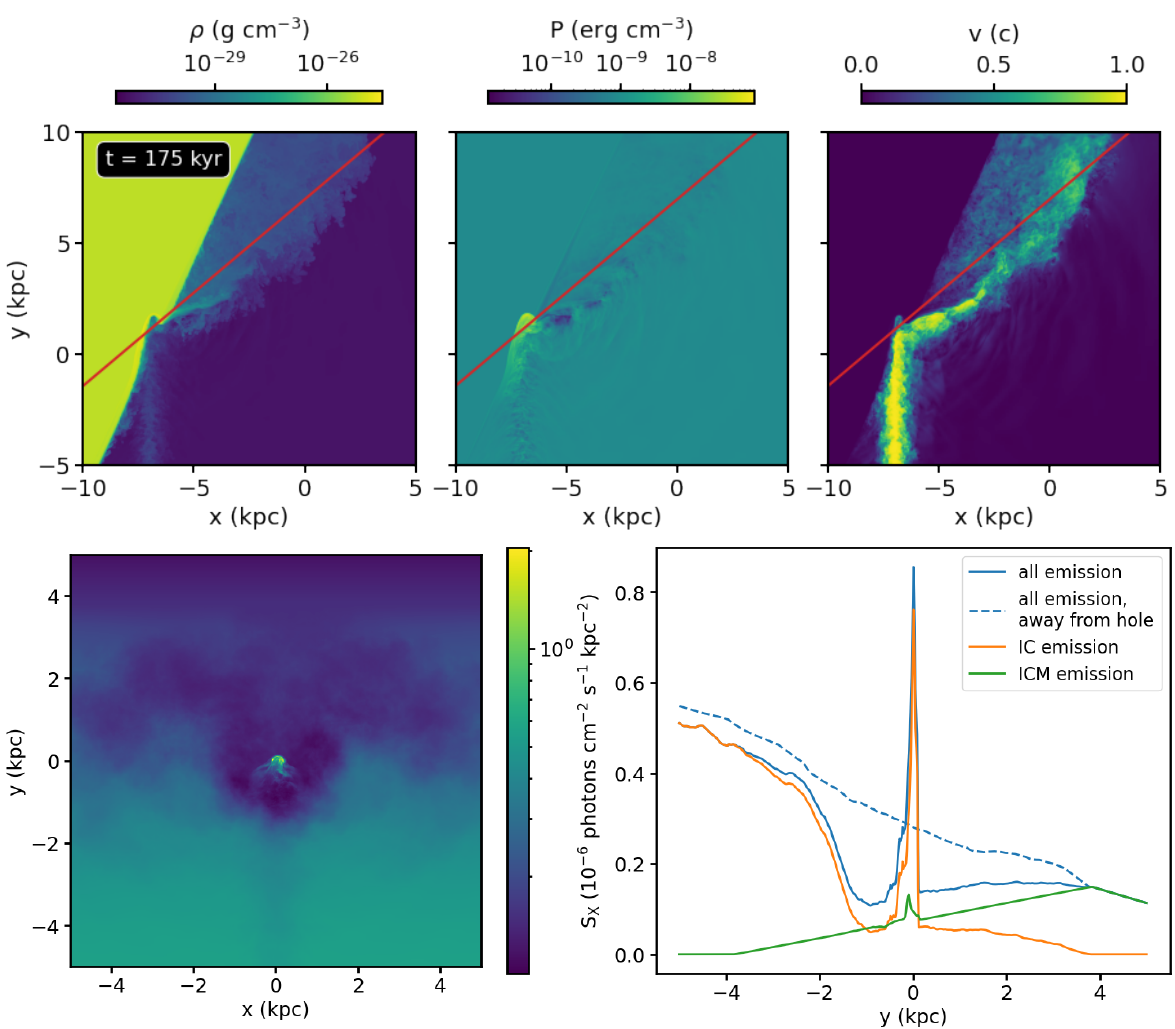
Figure 9. The appearance of a hole in X-ray emission due to Doppler de-boosting from the reflected jet. ( Top panels) Slices through the gas density, pressure, and velocity magnitude at t = 175 kyr, showing the line of sight of the projection in the bottom panels with a red line. ( Bottom-left panel) The projected X-ray surface brightness from all components along the chosen sight line, showing a hole of emission surrounding a hotspot. ( Bottom-right panel) Profiles taken through the center along the y -axis of the map at x = 0, showing separate IC-CMB and ICM thermal emission, as well as total emission in the hole region and away from the